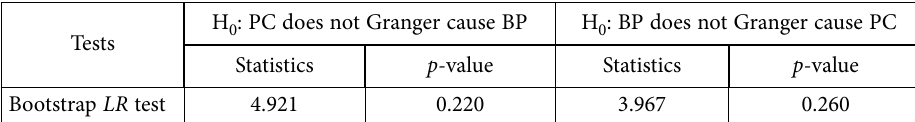
Table 2. Full-sample Granger causality